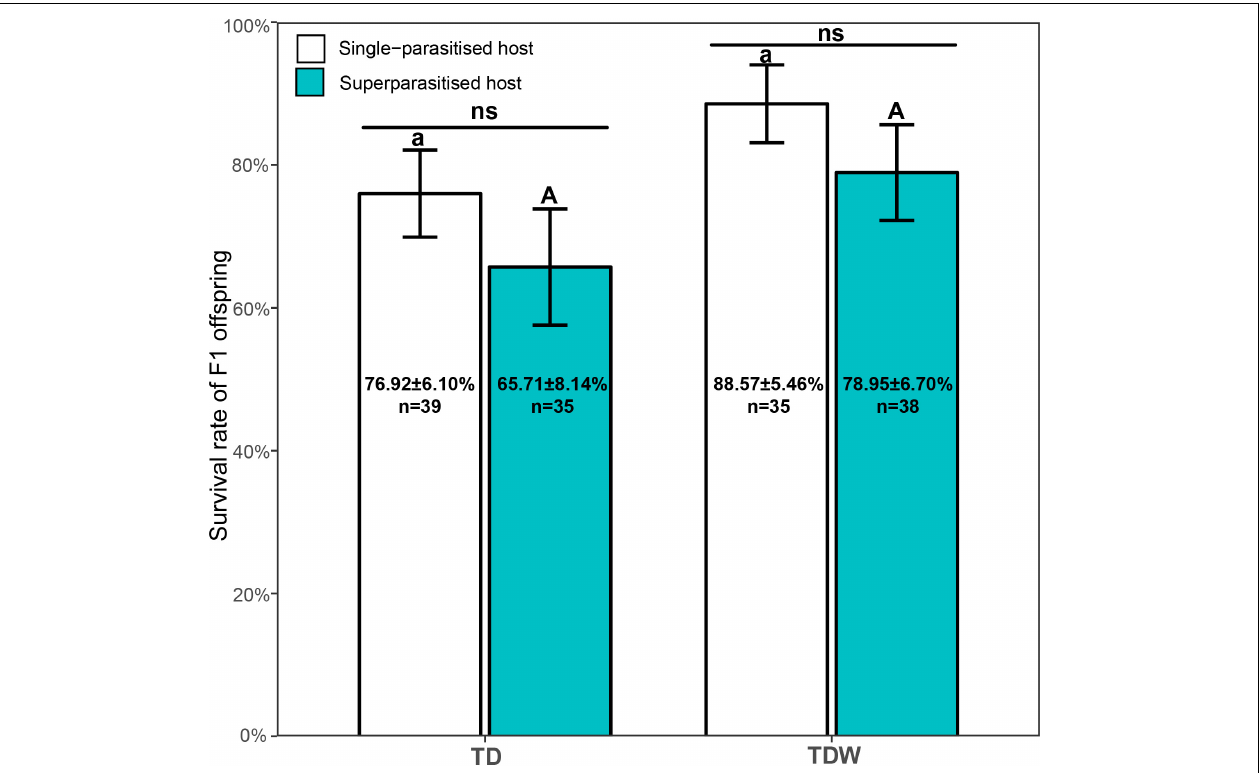
FIGURE 1 | Survival rate of TDW or TD F1 offspring in superparasitised (cyan bars) or single-parasitised (white bars) hosts. Bars indicate Means. Error bars indicate the interval of Mean ± Standard Error. The same uppercase letters indicate non-significant difference between TD ( n = 35) and TDW ( n = 38) in superparasitised hosts. The same lowercase letters indicate non-significant difference between TD ( n = 39) and TDW ( n = 35) in single-parasitised hosts. “ns” indicates non-significant difference between superparasitised hosts and single-parasitised hosts. Texts labeled on the bars indicate sample size and values of Mean ± Standard Error.